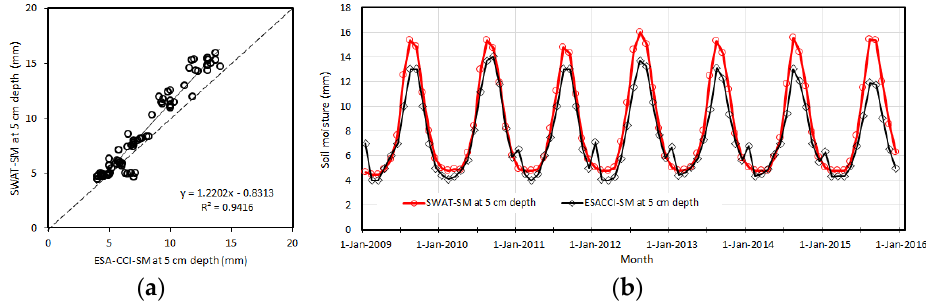
Figure 8. Comparison between monthly averaged SWAT SWC (black line) vs. ESA CCI SM (red